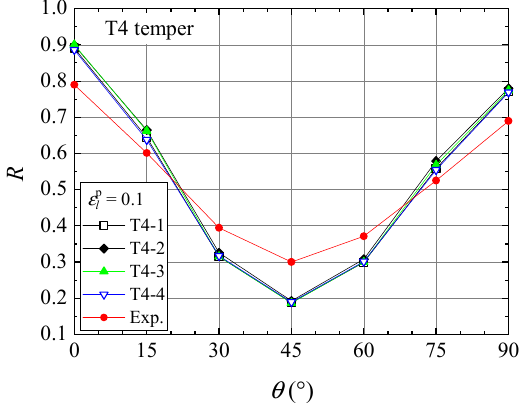
ε = are compared with = 0.1 are compared with l l